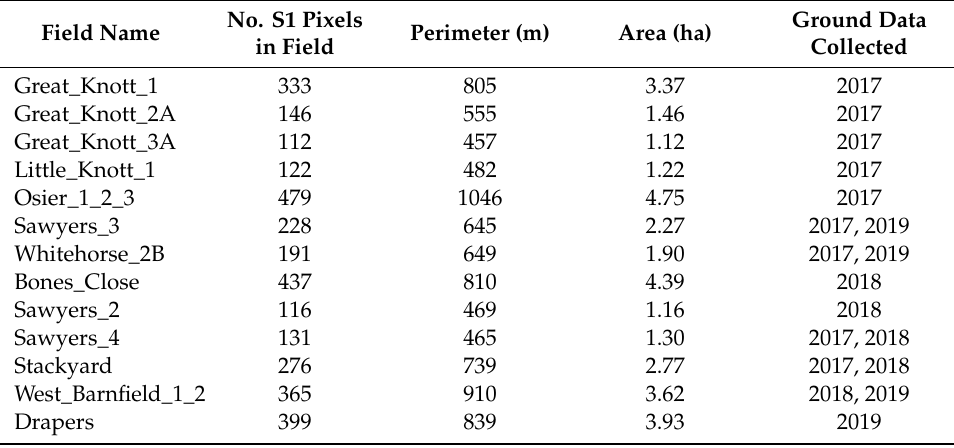
Figure 1. Google Earth image of Rothamsted Research experimental farm (coordinate system EPSG:27700), with wheat field boundaries from 2017, 2018, and 2019 indicated using red lines (see also Table 1). Table 1. Wheat field names and number of 10 × 10 m pixels per field on Rothamsted